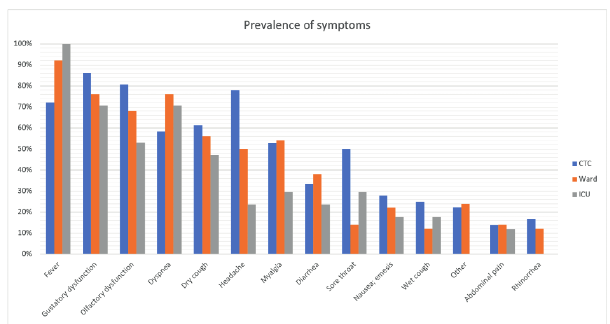
Figure 1. Other symptoms than smell and taste disorders at time of COVID-19 infection.